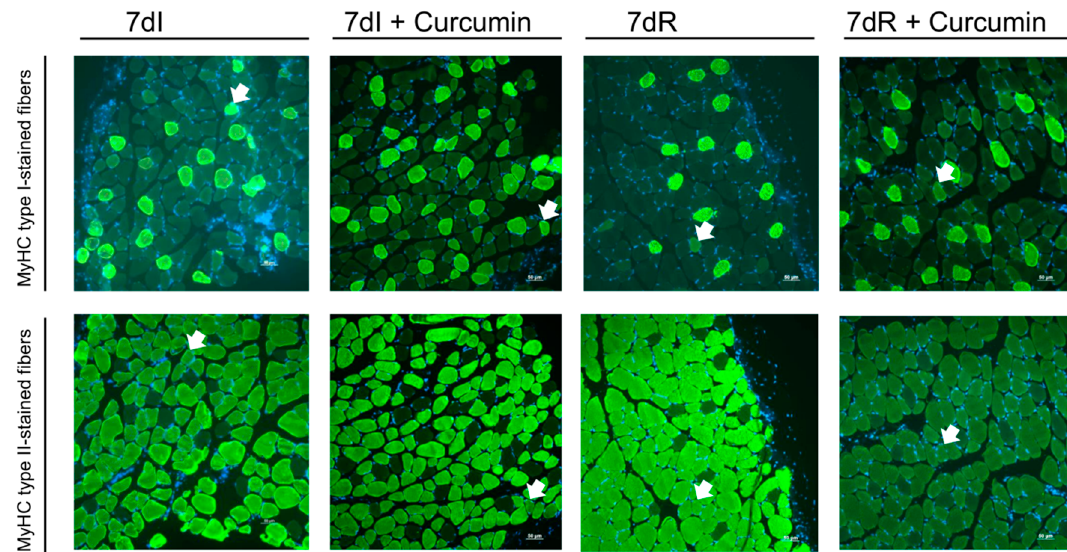
Figure 2. Representative examples of the gastrocnemius muscle in animals of the all study groups of mice. Myofibers were stained in green, type I in the top panel and type II in the bottom panel. Hybrid fibers (arrows) are seen in both panels. Definition of abbreviations: MyHC myosin heavy chain; I, immobilization; R, recovery.